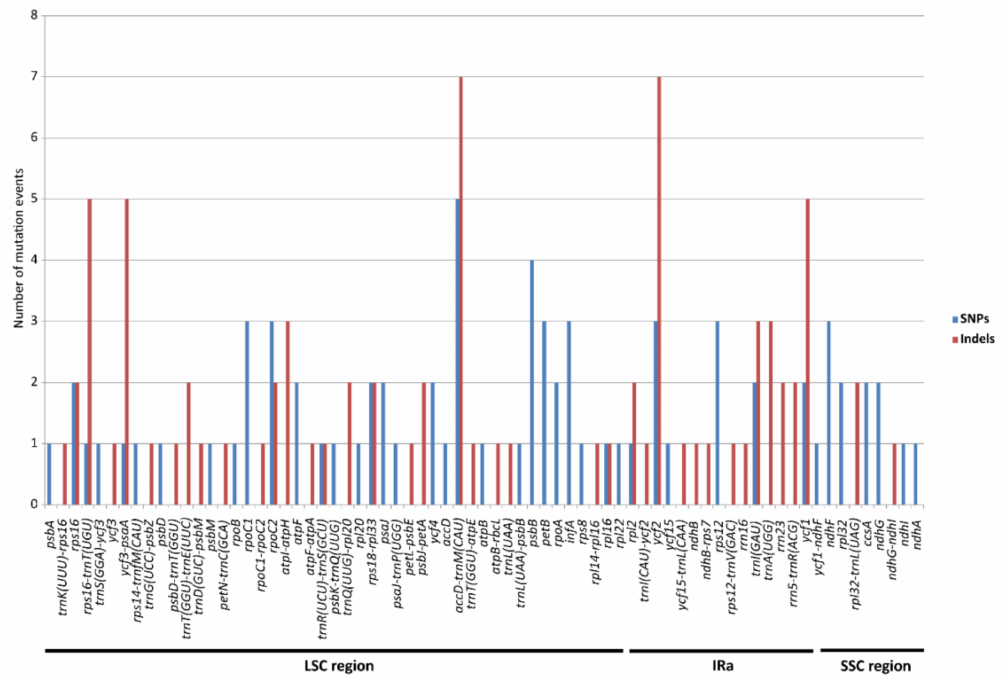
Figure 2. Mutational events (SNPs and indels) detected across the chloroplast genome of Eucommia ulmoides . SNPs (single nucleotide polymorphisms) indicate nucleotide substitutions and indels represent nucleotide insertions and deletions. The homologous loci are oriented according to their locations in the chloroplast genome.